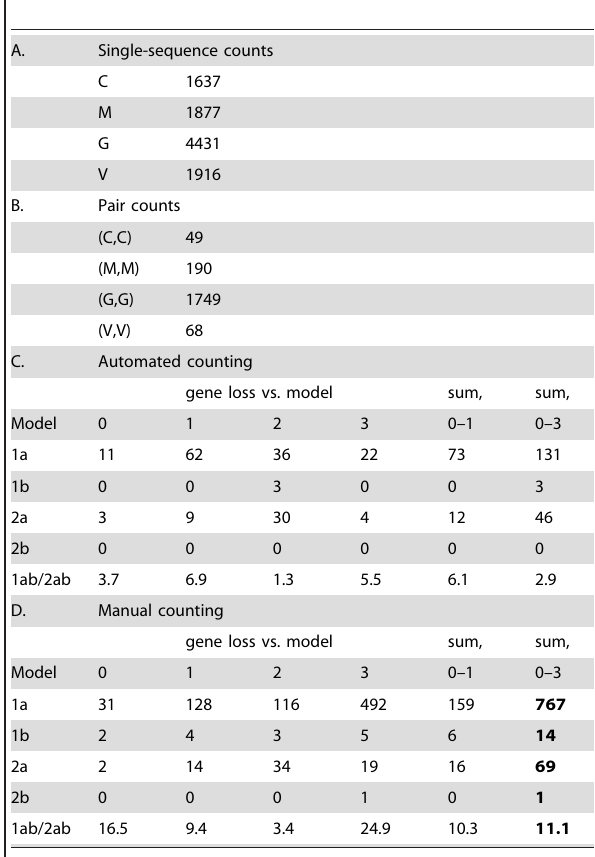
Table 1. Summary of clade-pattern counts from 1249 informative phylogenetic